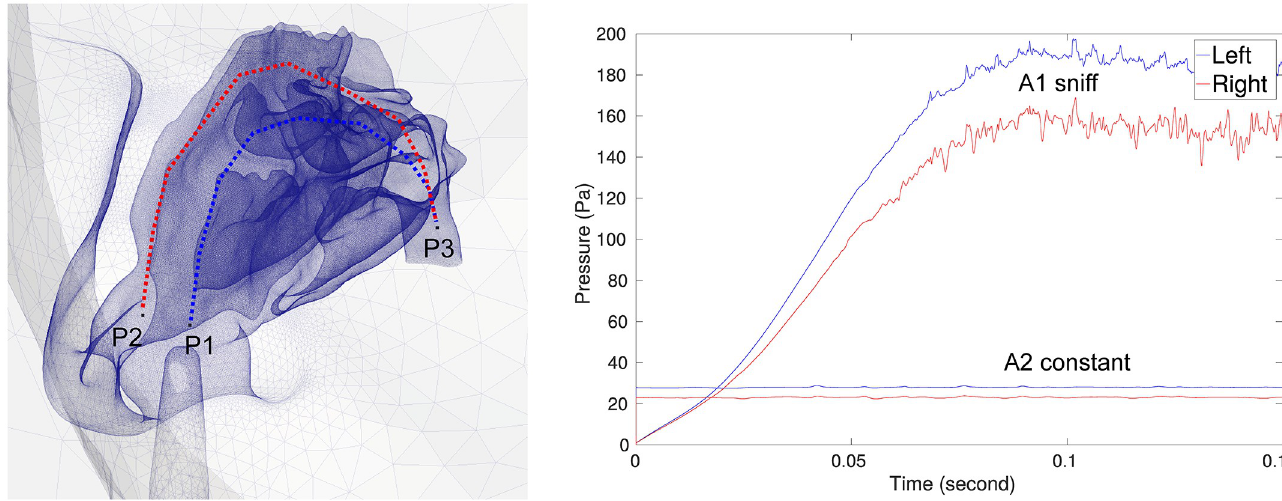
Fig 10. Static pressure drop across the right and left nasal cavity during time period (0.0s to 0.15s] for A1 and A2 inhalation conditions.